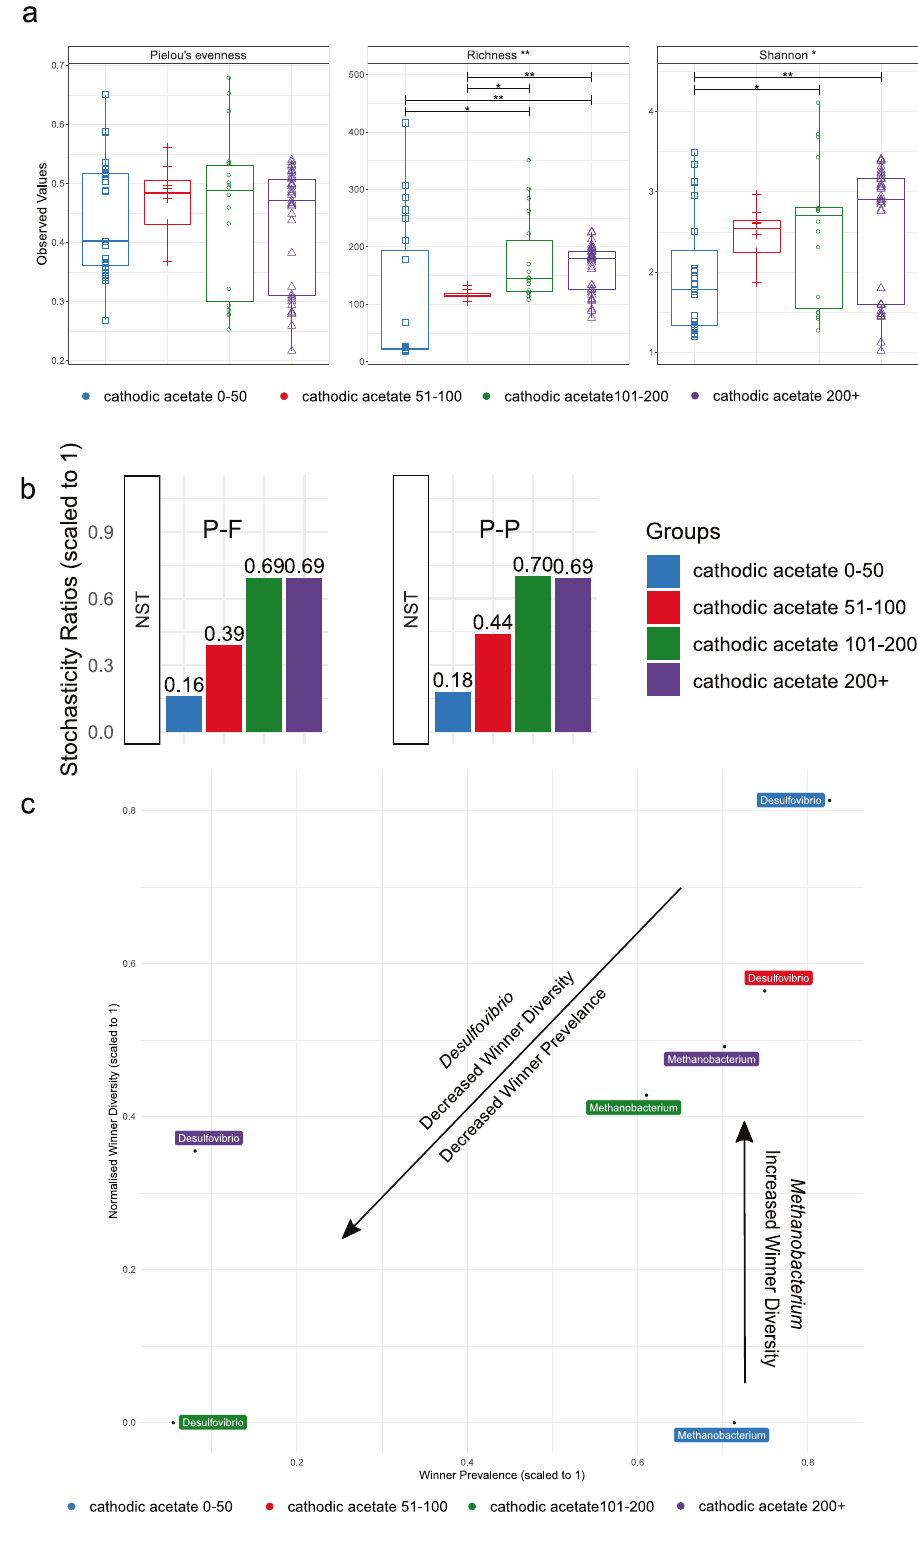
reducing equivalents) than the organism performing acetogen- esis. No correlation was found between Sulfurospirillum sp. abundance and CE. However, it correlated positively with production rate, con fi rming the importance of its oxygen scavenging role in MES. As expected, methanogens such